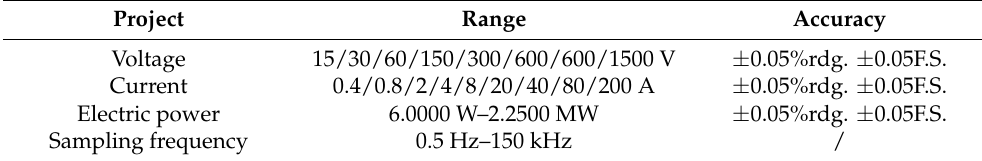
Table 4. The performance parameters of HIOKI3390 high precision power